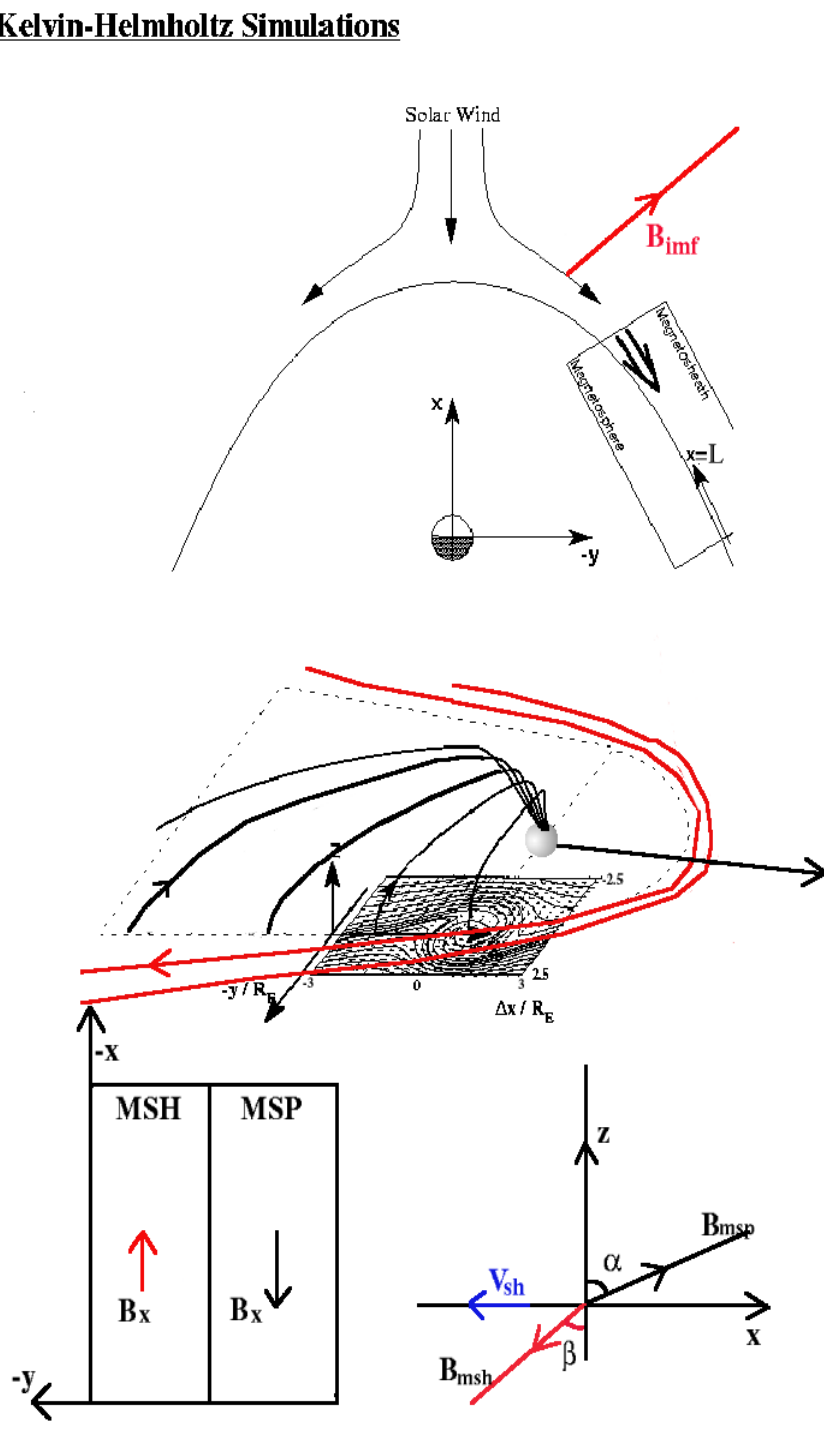
Fig. 10. Simulation geometry.